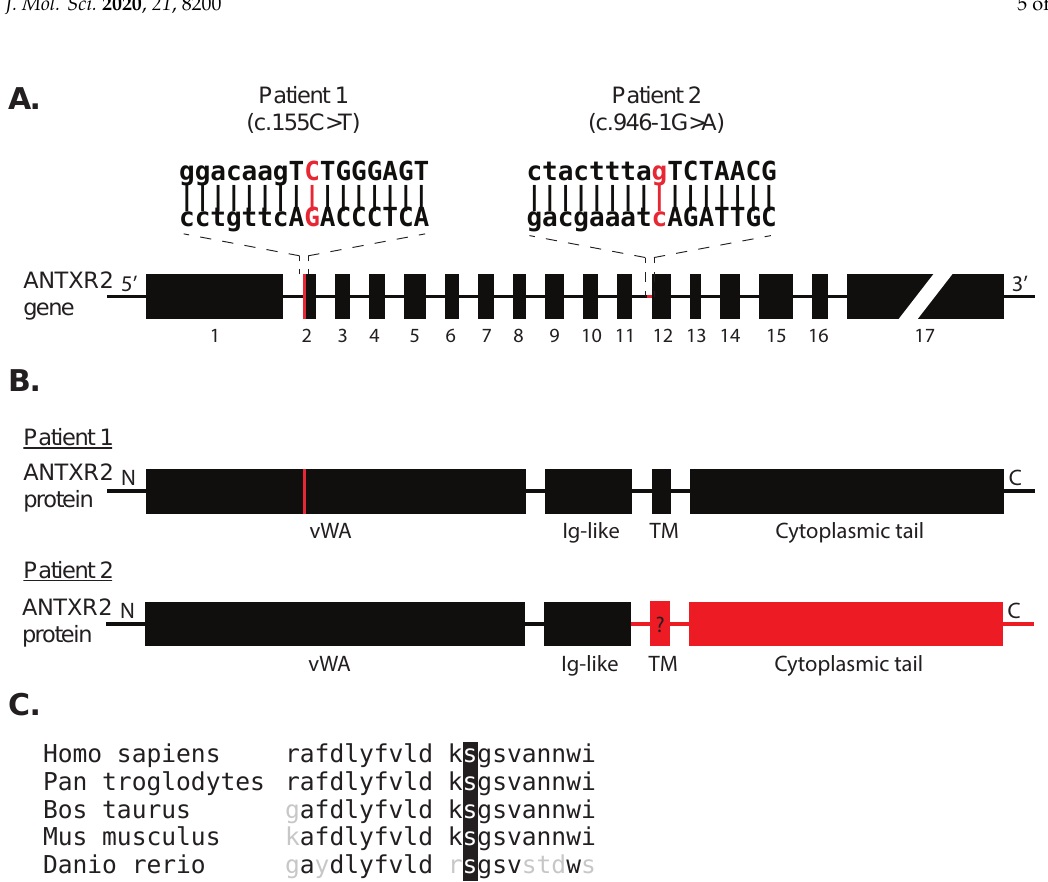
Figure 2. Characteristics of the ANTXR2 mutations. Schematic of ( A ) the genetic localization of the mutations (indicated in red) and ( B ) the e ff ect of the mutation in the ANTXR2 protein of Patient 1 (c.155C > T, red bar) and Patient 2 (c.946-1G > A). The splice-site mutation of Patient 2 likely leads to loss of protein (deletion indicated in red). ( C ) The mutated serine residue of Patient 1 is highly conserved across among the amino acid sequences of various vertebrates, suggesting critical functional